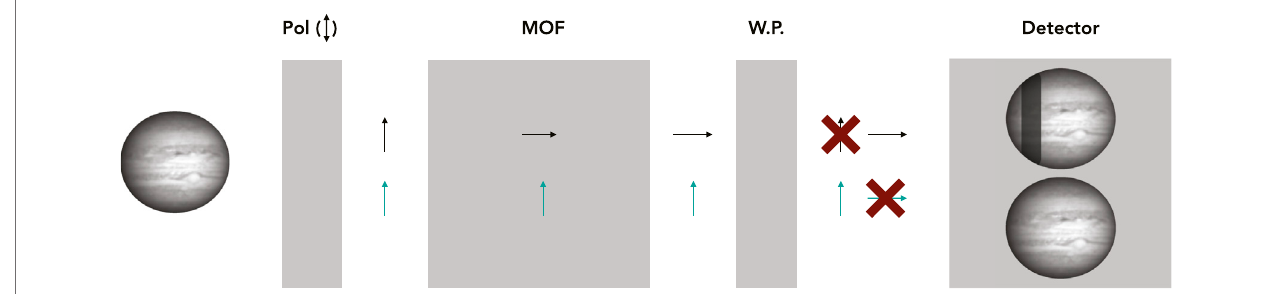
FIGURE1| VisualizationofthepathoflightthroughaMOFlocatedbetweentwocrossedpolarizers.Theblackarrowsrepresentlightinthewingsoftheabsorption line,whilethegreenarrowsrepresentthecontinuumportionoflightoutsideoftheabsorptionline.Thelight fi rstpassesthroughaverticallyorientedpolarizer,thenintothe heated vapor cell enclosed in a permanent magnet assembly, applying a magnetic fi eld parallel to the optical path. 1) The light in the wings of the absorption line (black arrow) experiences a rotation of its polarization state, allowing it to pass through the fi nal polarizer (a Wollaston prism), which separates the vertical and horizontal polarizationstatesandprojectsthemontothedetector,wheretheabsorptionlinepro fi leisnowvisibleonthe “ velocity ” or “ MOF ” image.2)Thecontinuumportionoflight (green arrow) is unaffected by Faraday rotation within the MOF and passes unattenuated through the MOF and the Wollaston prism, maintaining its original vertical polarization state and thereby producing a “ continuum ” image on the